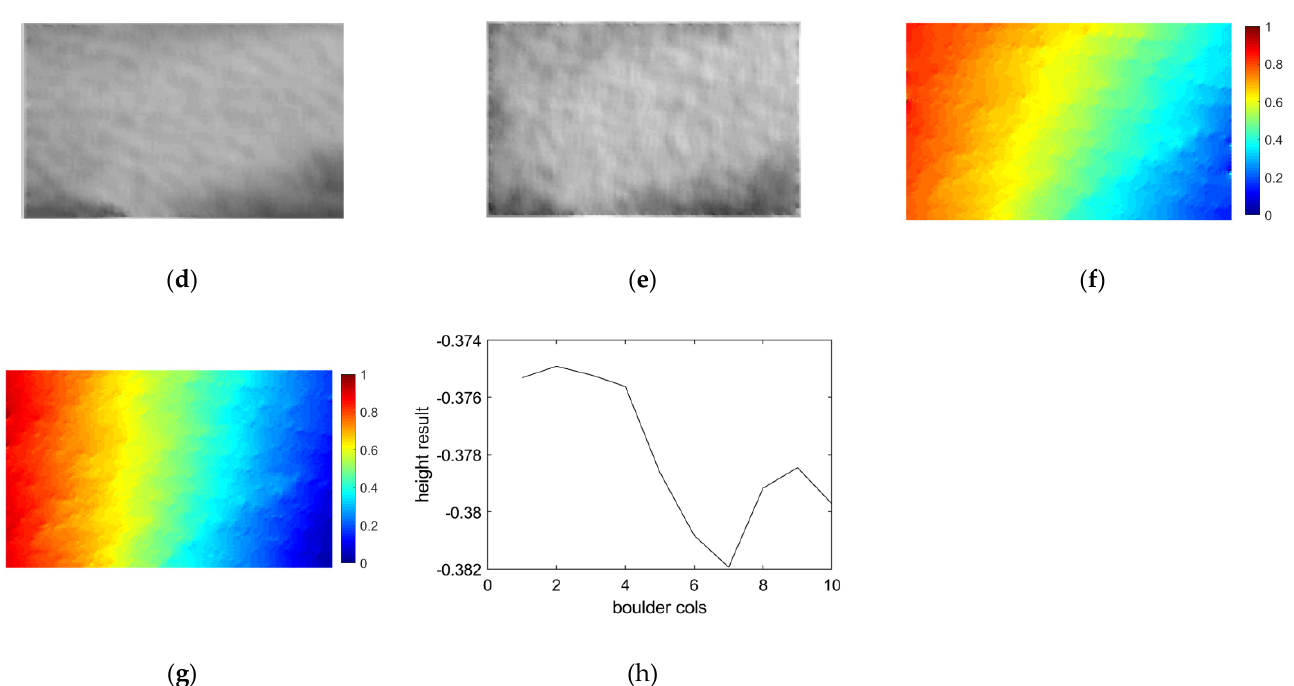
Figure 17. ROI 2 and reconstruction results of the three methods ( a ) ROI 2 image, ( b ) SGM result, ( c ) PPS result, ( d ) shaded SGM result, ( e ) shaded PPS result, ( f ) PSPP result, ( g ) PSOP result, ( h ) Profile of the boulder (marked by the white circle in ( a )) from PPS result.